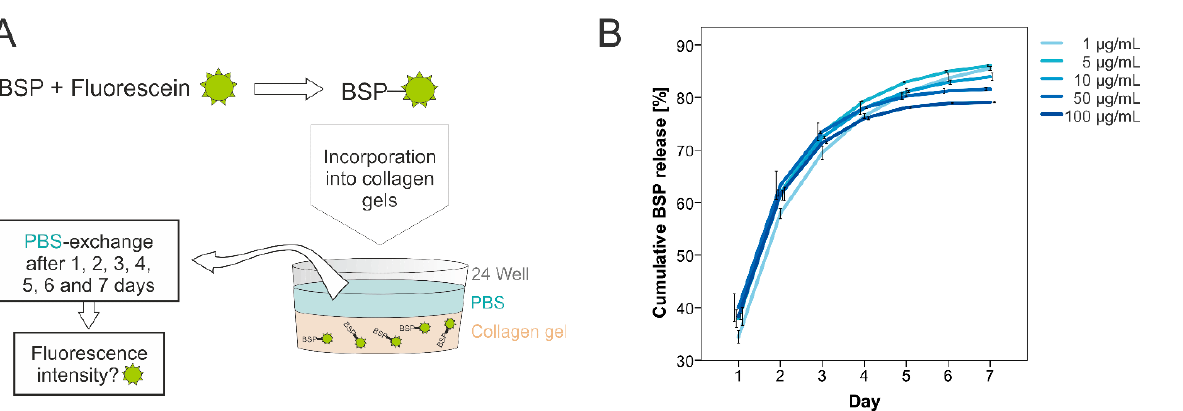
Figure 1. BSP release. ( A )—Fluorescein-coupled BSP was incorporated into collagen gels. The gels were covered with PBS solution that was exchanged every day, followed by measuring the solutions’ fluorescence intensity. ( B )—Cumulative BSP release from collagen type I gels. Different concentrations were used for the release assays (1–100 µ g/mL). The diagram shows the BSP release presented as cumulative percentage ( n = 3 per concentration).